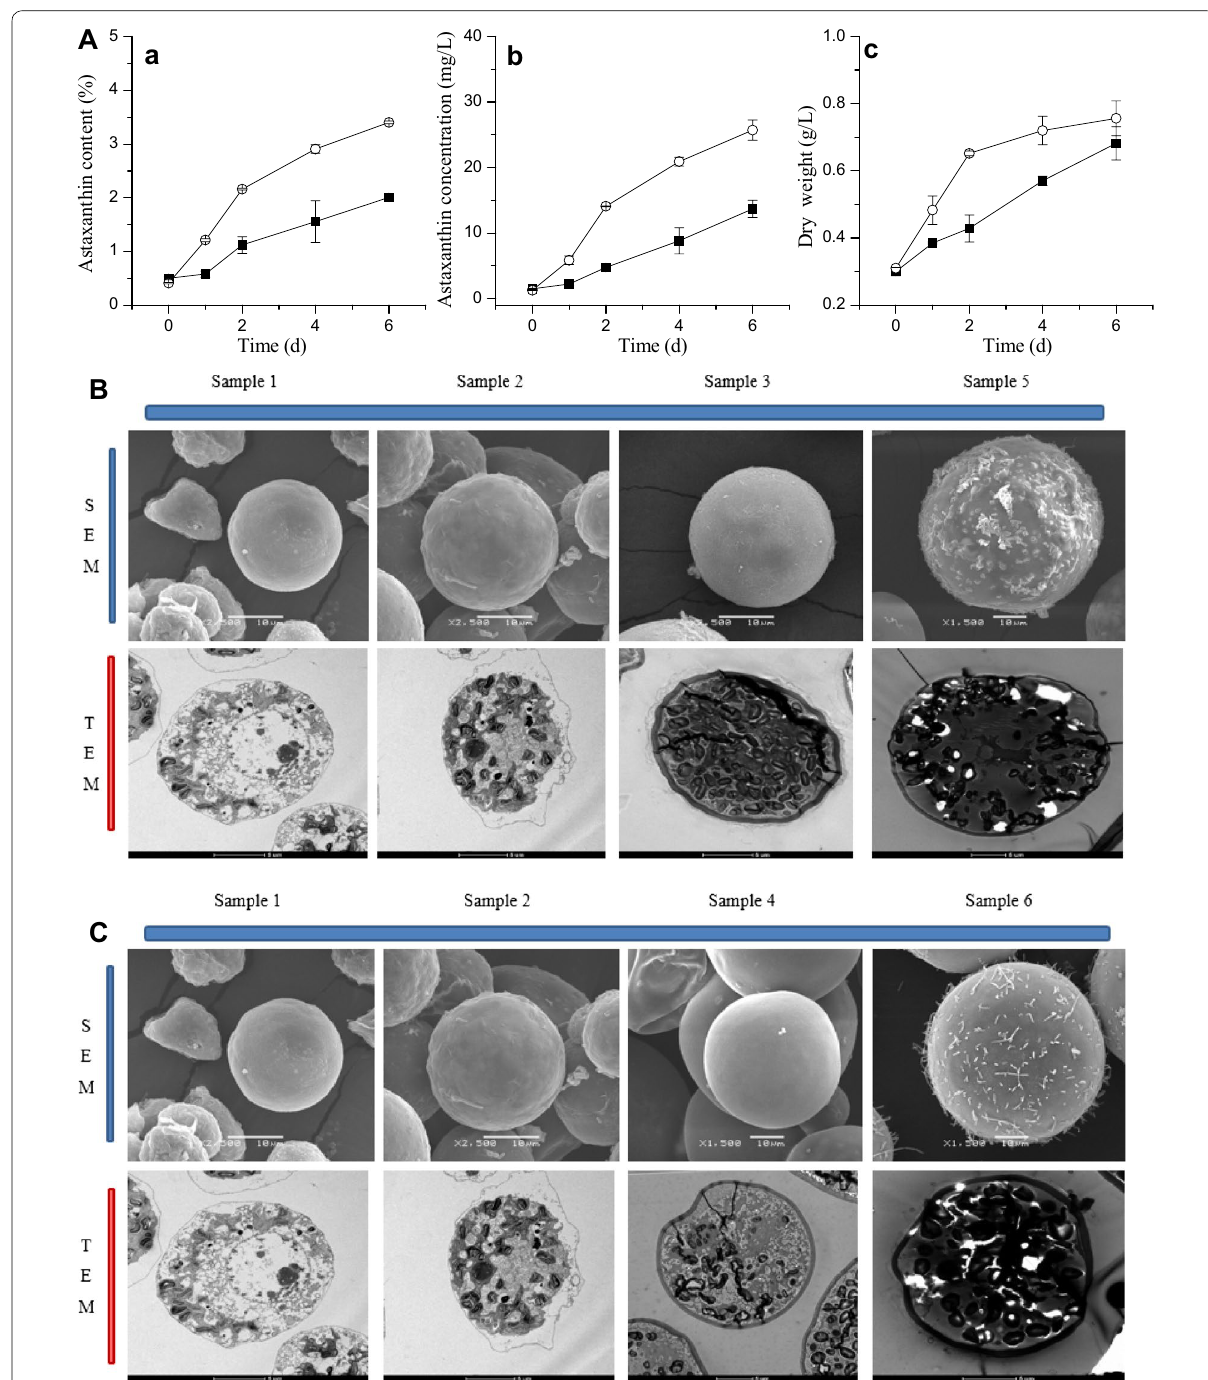
Fig. 2 Induction effect and images of H . pluvialis using different cell type as seeds. A Induction effect of H . pluvialis using different cell type as seeds. a Astaxanthin content during induction process; b astaxanthin concentration during induction process, c dry weight during induction process. Hollow circle represents green non-motile cells as seeds, and solid square represents brown akinetes as seeds; b , c represent SEM and TEM images of control group ( B , 1235 route) and treatment group ( C , 1246 route), respectively. Sample 1, Sample 2 and Sample 3 were the heterotrophic cells at 100 h, 250 h, and 550 h, respectively; Sample 4 was Sample 2 cells induction for 0.5 day; Sample 5 was Sample 3 cells induction for 6 days; Sample 6 was the Sample 2 cells induction for 6 days. SEM: scanning electron microscope (scale bar 10 μm); TEM: transmission electron microscope (scale = bar 5 μm). Data are shown as mean SD, and number of replications is two ( n = ± =